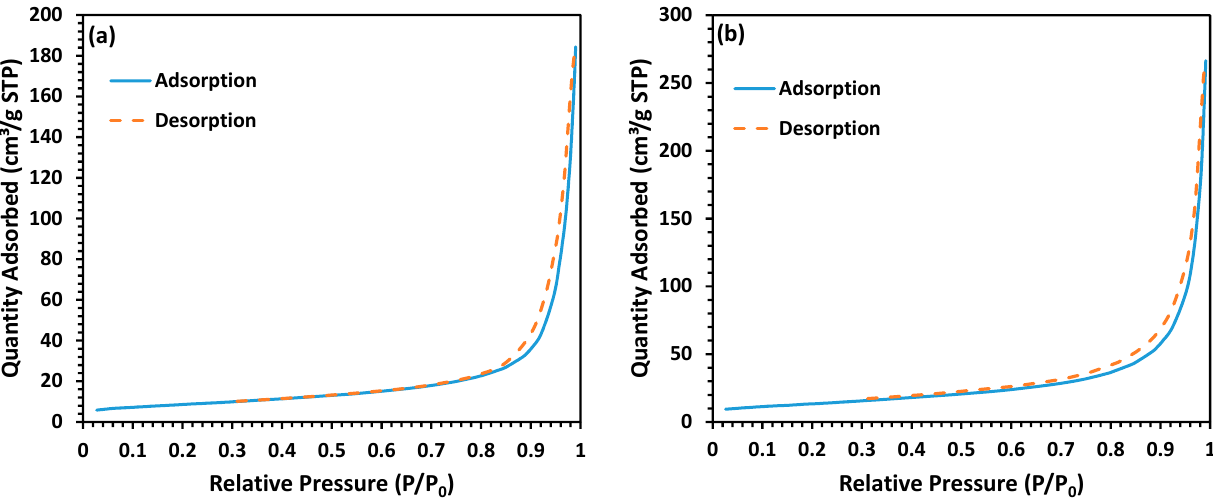
Figure 4. N 2 adsorption/desorption isotherms at 77 K for MnZn ferrite nanopowders with ( a ) normal morphology, and ( b ) hierarchical morphology.